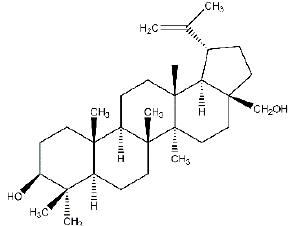
Figure 2. Betulinol molecule structure.